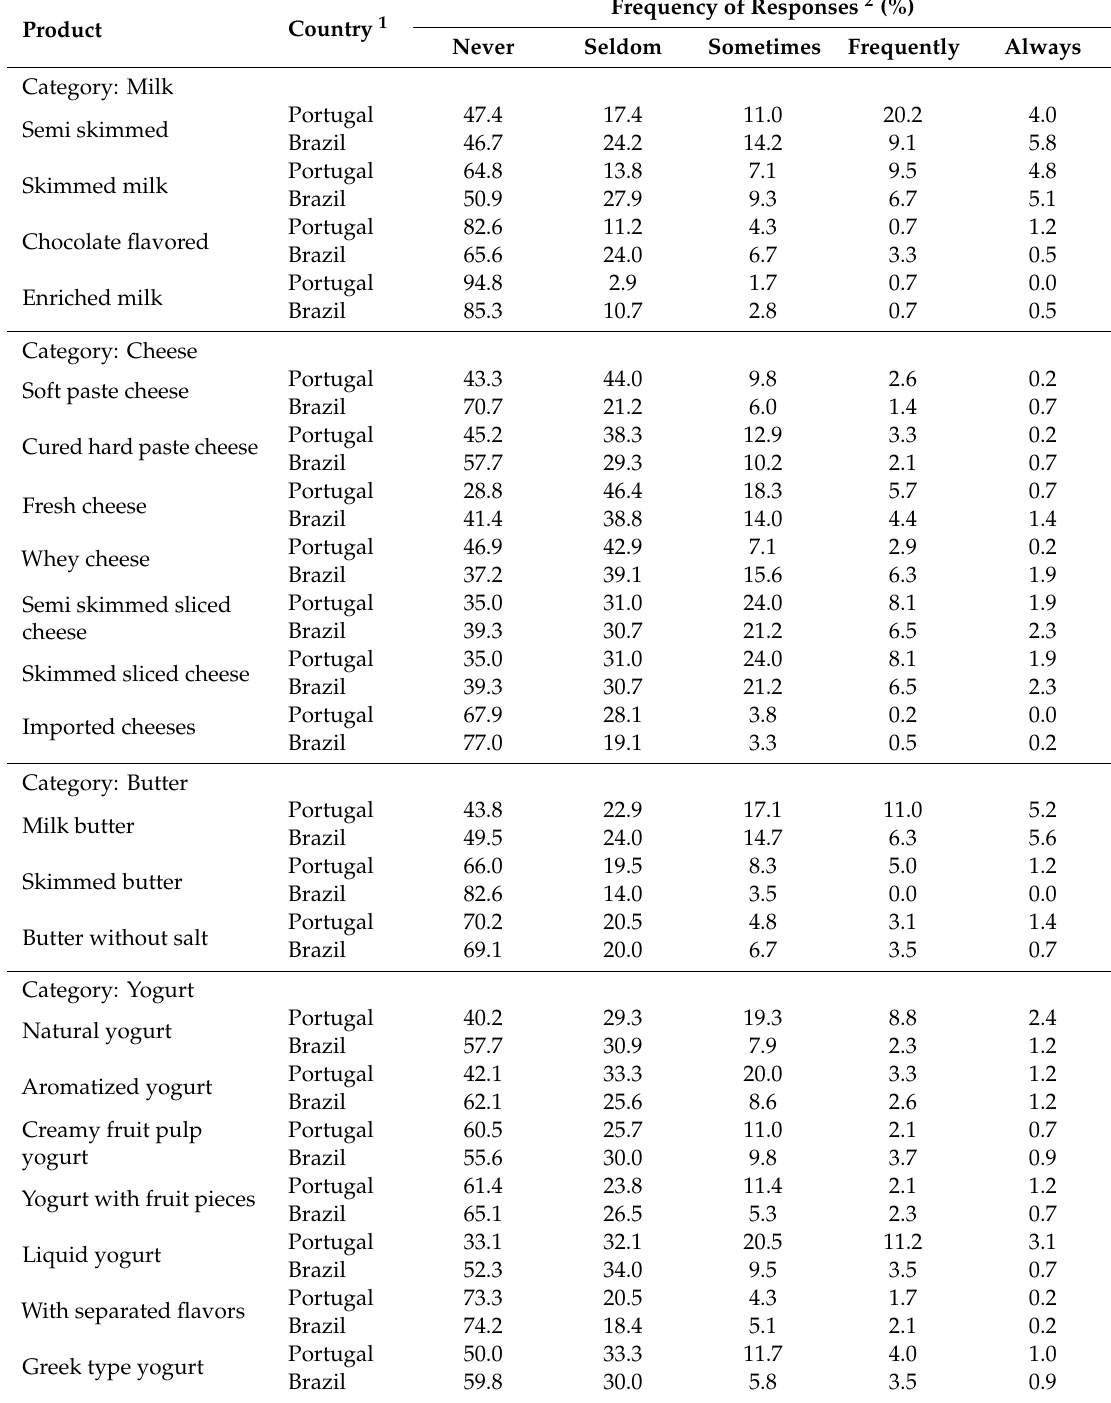
Table 12. Frequency of consumption of dairy products in Portugal and Brazil. Frequency of Responses 2 (%) Country 1 Never Seldom Sometimes Frequently